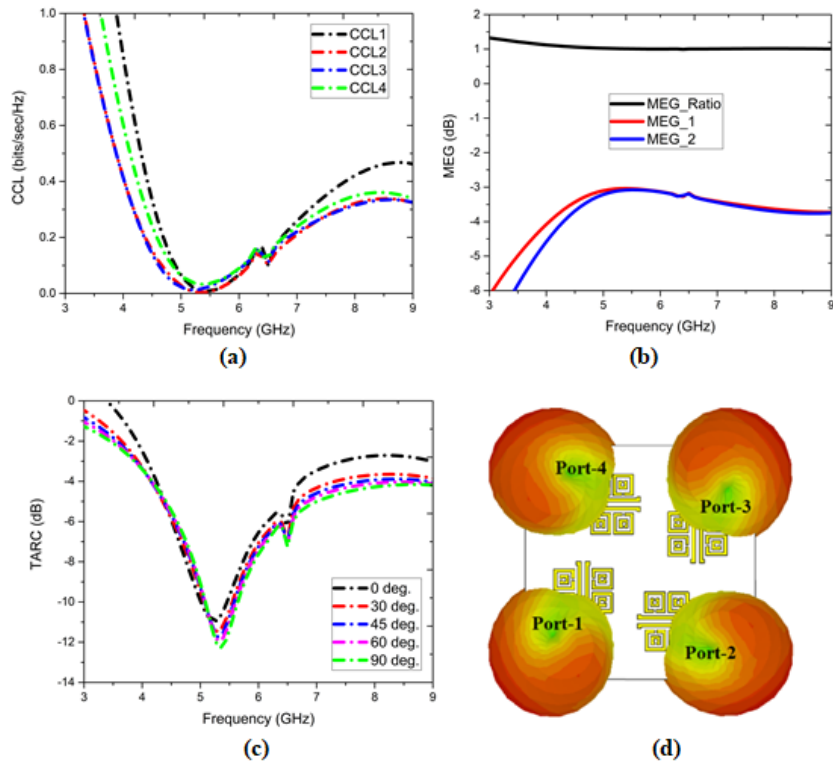
Figure 24. ( a ) Channel capacity loss (CCL), ( b ) mean effective gain (MEG), ( c ) total active reflection coefficient (TARC), and ( d ) 3D far-field radiation pattern of the four-element antenna configuration.